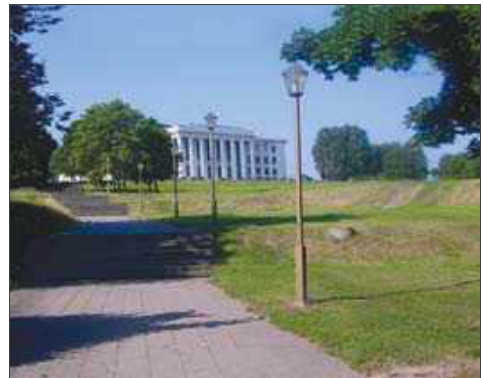
Fig. 12. contemporary view of the building on tauras